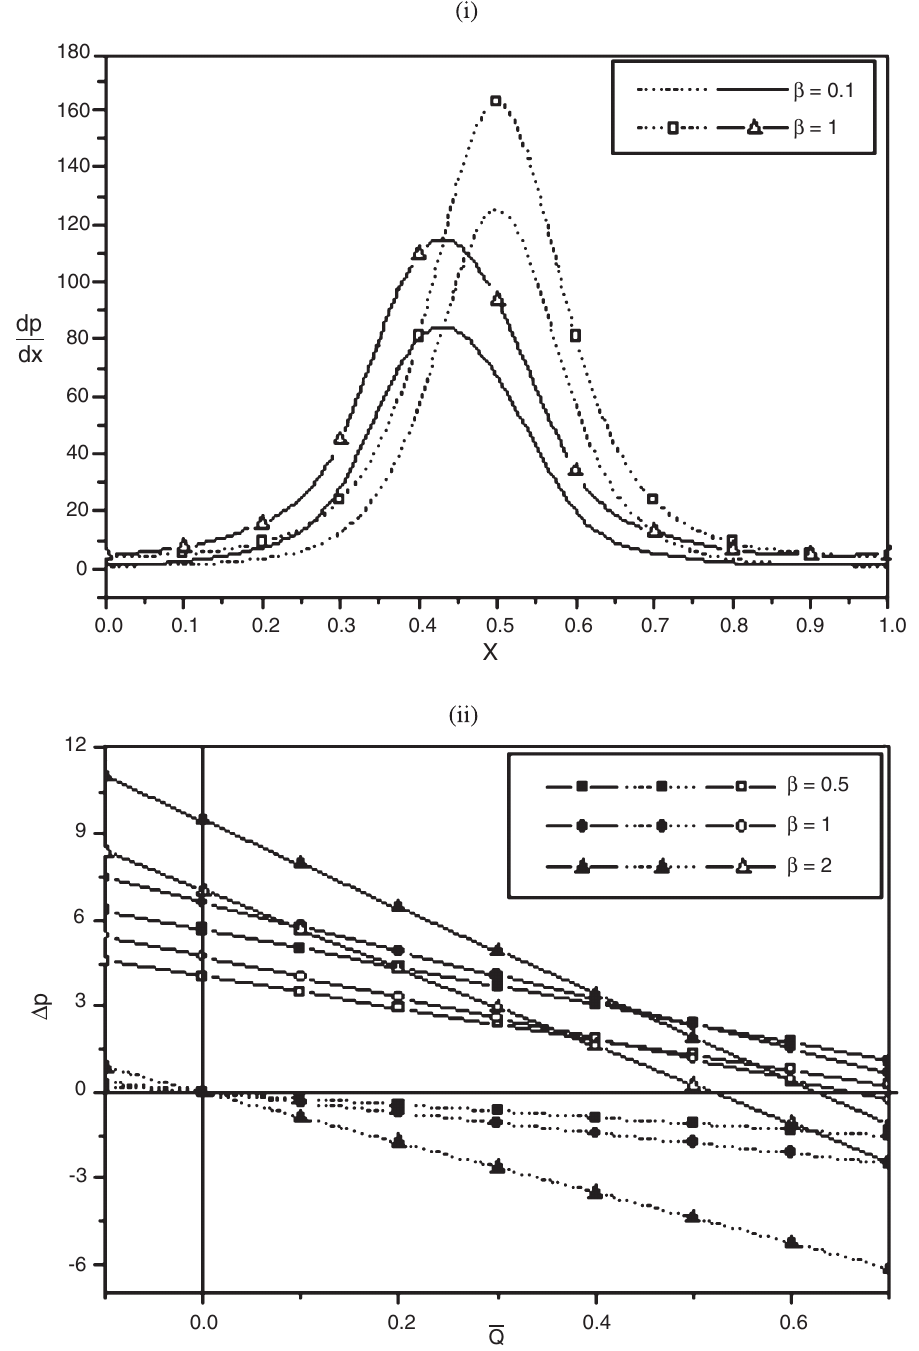
Fig. 2. (i) Variation of dp/dx versus x for different values of β with a = b = 0 . 6 and (i) φ = 0 (dot lines), (ii) φ = π/ 4 (solid lines). (ii) Variation of (cid:9) p versus Q for different values of β with a = b = 0 . 6 and (i) φ = 0 (solid lines with closed mark), (ii) φ = π/ 4 (solid lines with open mark), (iii) φ = π (dot